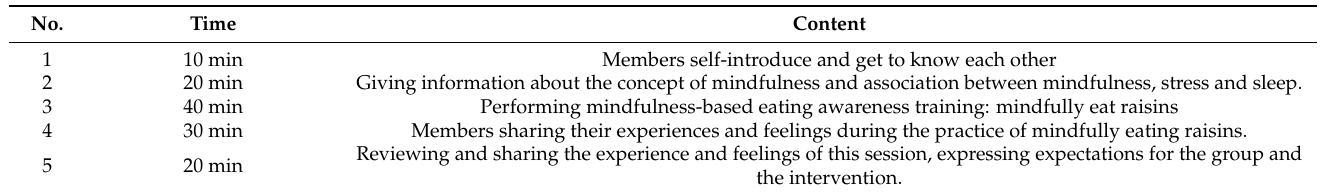
Table 2. The content of session 1 of the group-based